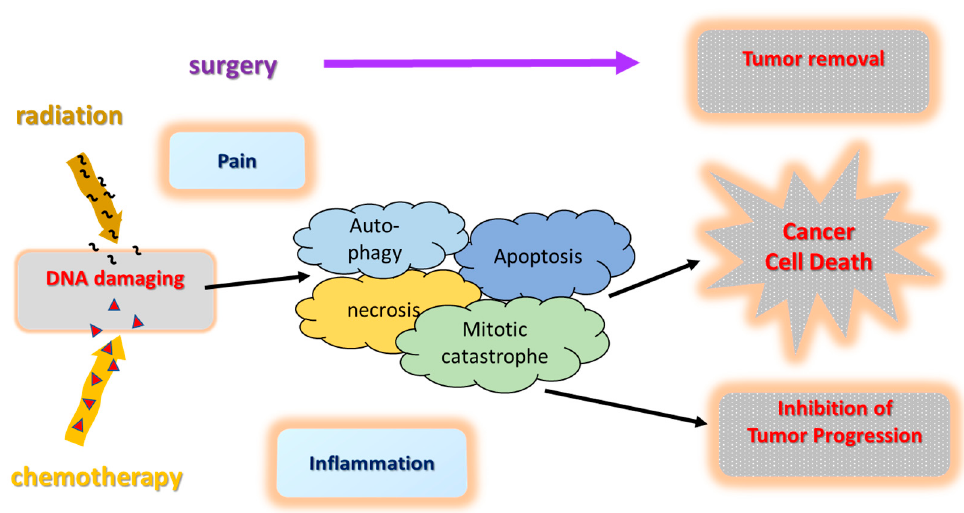
Figure 1. Simplified overview of the mechanisms of standard treatments.